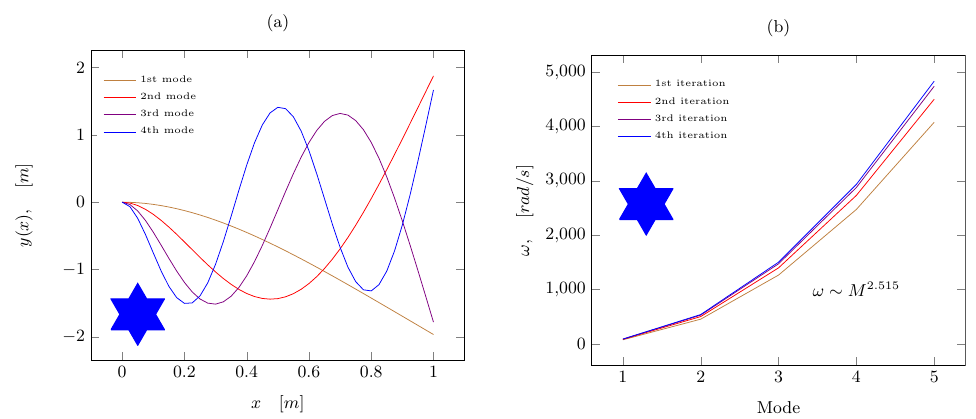
Figure 4. Mode shapes and natural frequency for solid cross section. ( a ) Cross section is the first iteration of Koch snowflake and ( b ) natural frequency for shape modes 1, 2, 3, 4 and